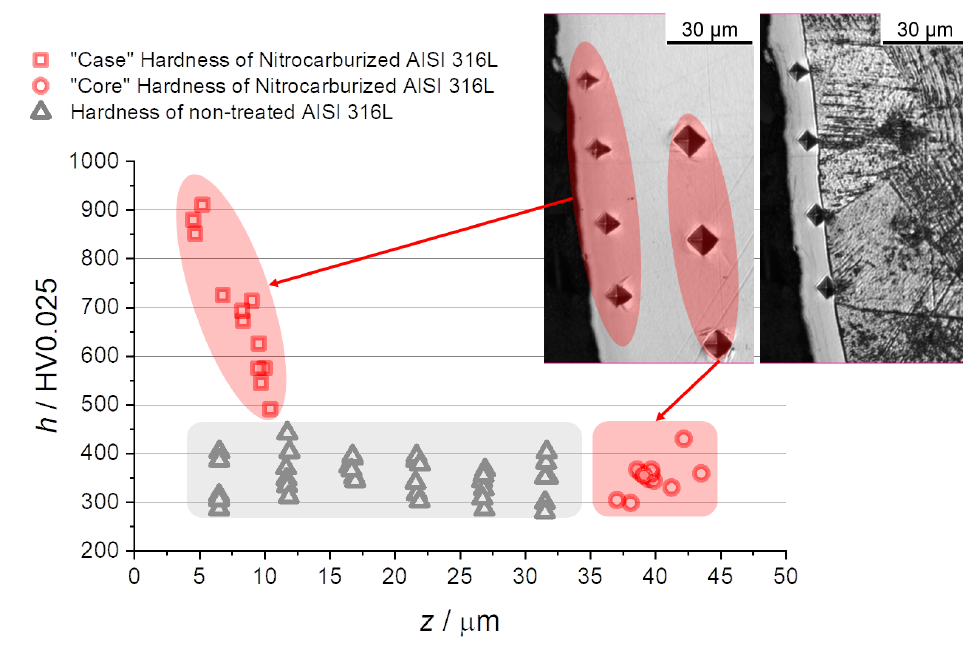
Figure 3. Microhardness–depth profile h [ z ] recorded in the region of the solute-rich “case” and the region of the non-infused “core.” Hardness values (red data points) in the two regions of the nitrocarburized AISI-316L are highlighted and related to the indents seen on a light-optical micrograph of the polished cross-section of the alloy specimen. The etched cross-section at the same location displays the “case” and “core” regions. The gray data points at the bottom left were obtained from a non-treated (as-received) AISI-316L